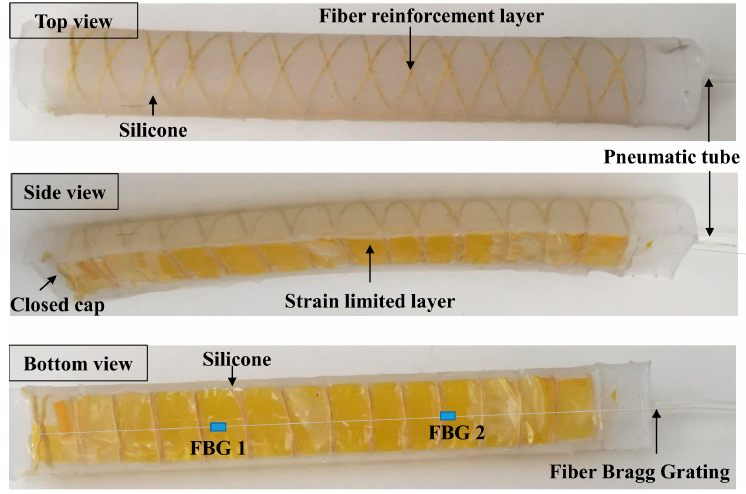
Figure 4. 3D printed mold of the soft actuator.